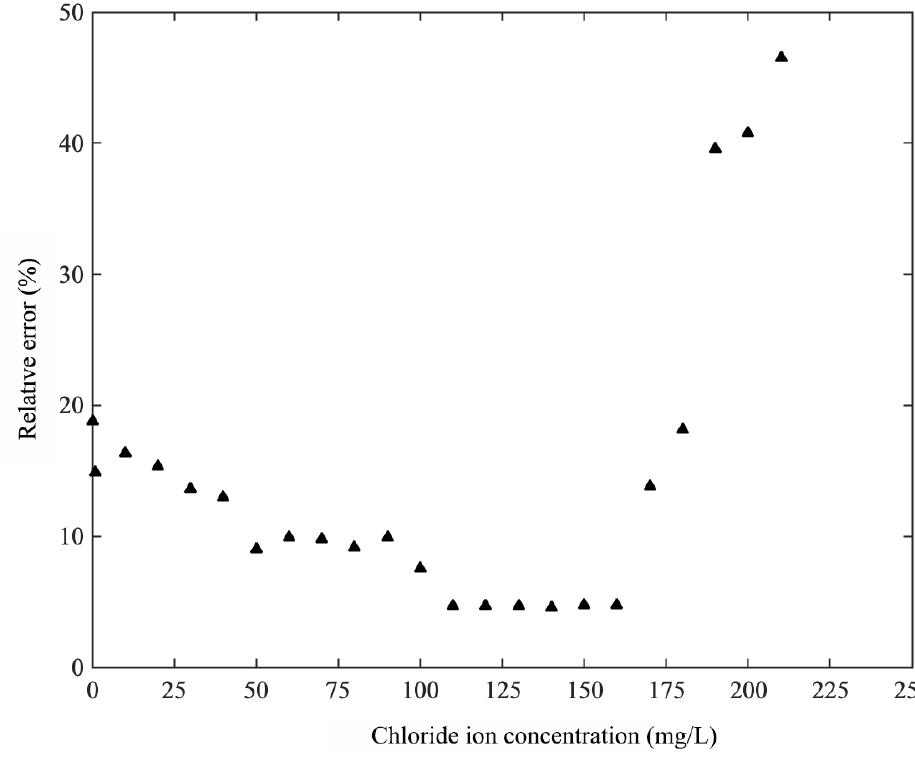
Figure 4. Error distribution for different tracer concentrations of chloride ions. (solid triangle denotes different concentrations of chloride ions).